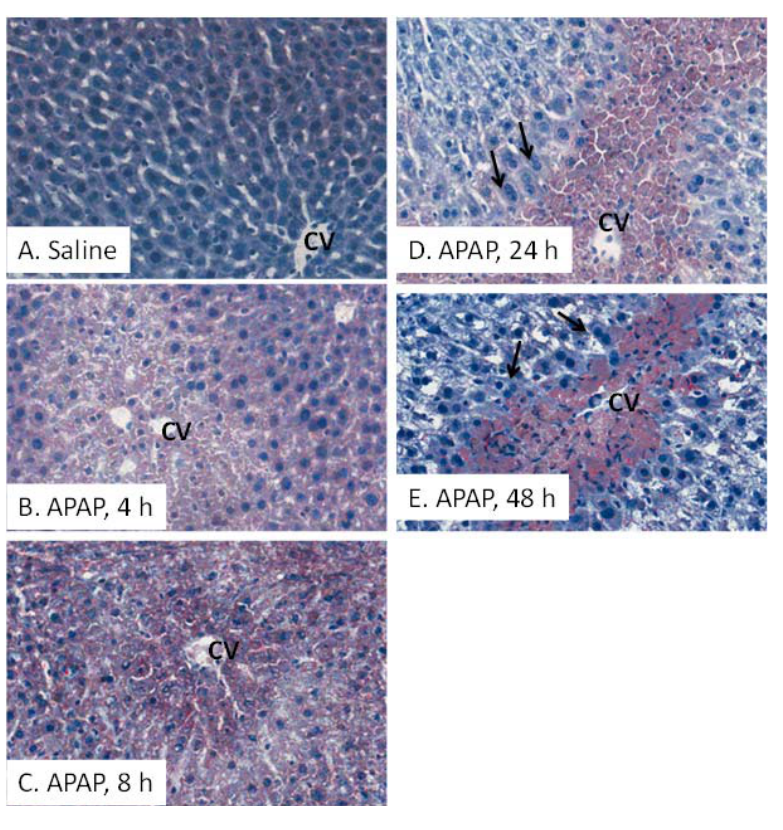
Figure 4. Oil Red O (ORO) staining in saline and APAP treated mice. Representative slides of ORO staining of mice treated with saline ( A ) or 200 mg/kg APAP and sacrificed at 4 ( B ), 8 ( C ), 24 ( D ) or 48 h ( E ). A diffuse pattern of ORO staining, indicative of hepatic lipid accumulation, was observed at 2 h (not shown) and peaked at 4 h. By 24 h, ORO staining was localized to the necrotic regions, adjacent to areas of regenerating hepatocytes